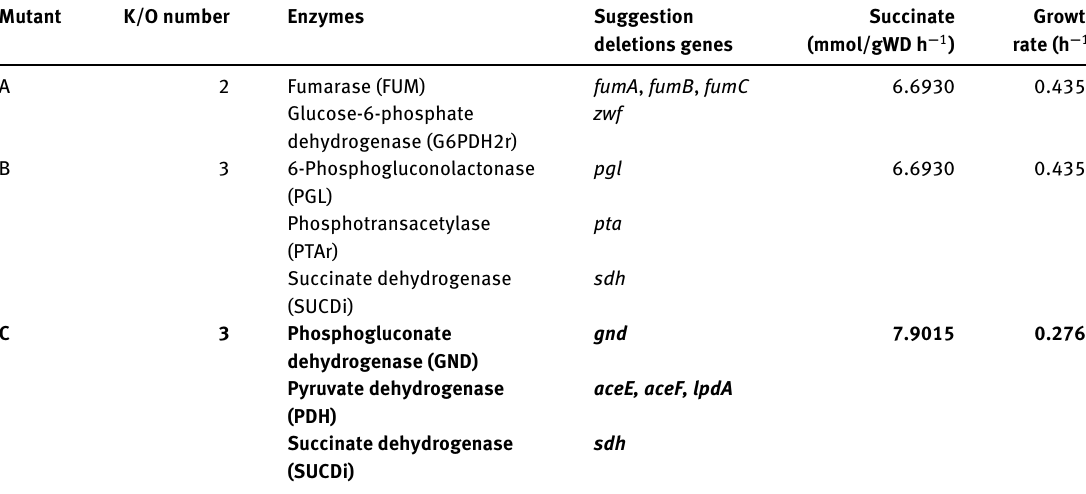
Table 1: Knockout lists for succinate in E. coli .